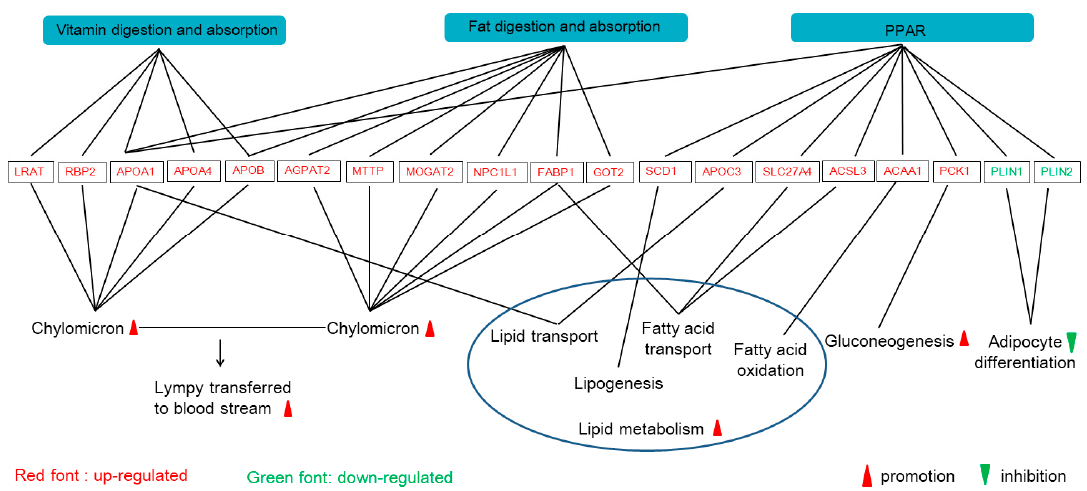
Figure 4. The signaling network of the gene and biological functions caused by the two times feeding regimen. The relationships between the genes and biological function are indicated by the lines.